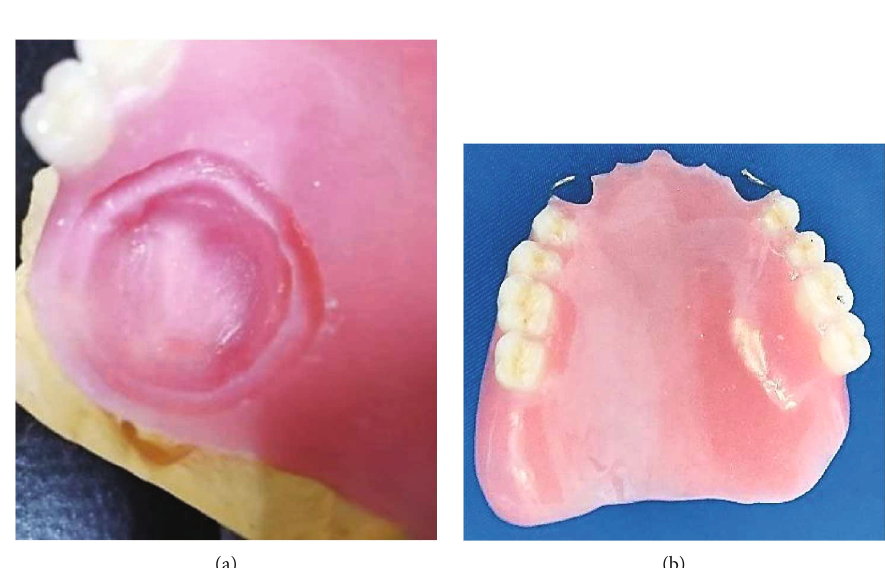
Figure 9: (a) Hollowing the prosthesis. (b) Prosthetic extrados aspect.